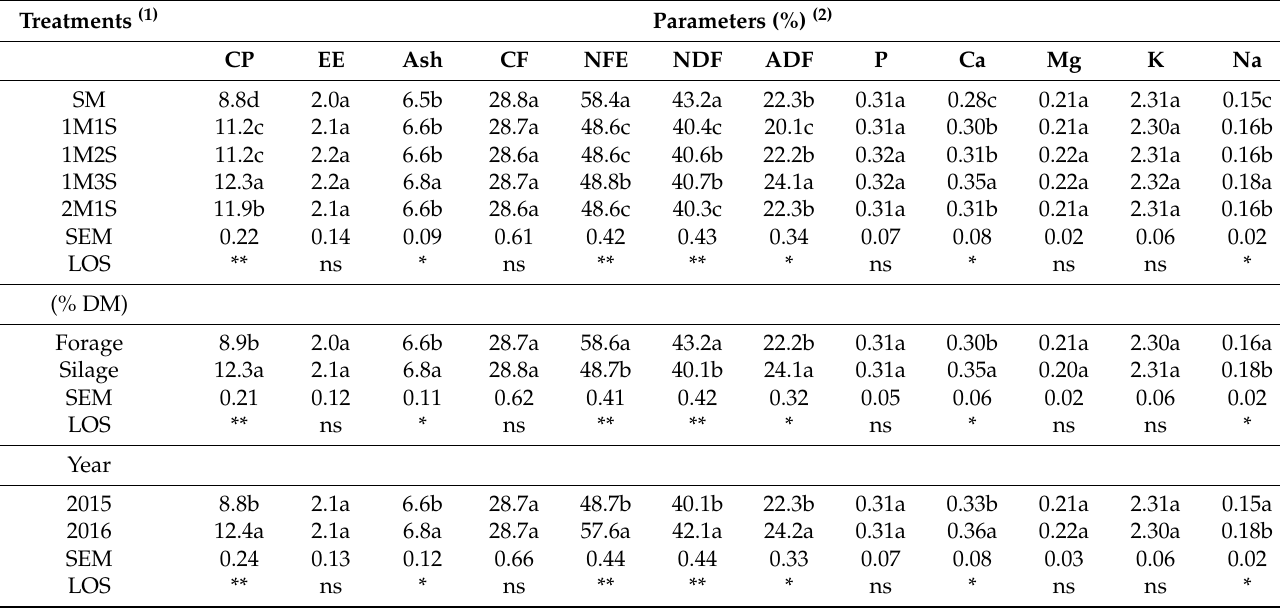
Table 4. Proximate analysis and mineral compositions of forage and silage of maize and intercropped maize and soybean (% DM) at harvested time of two maturity stages.